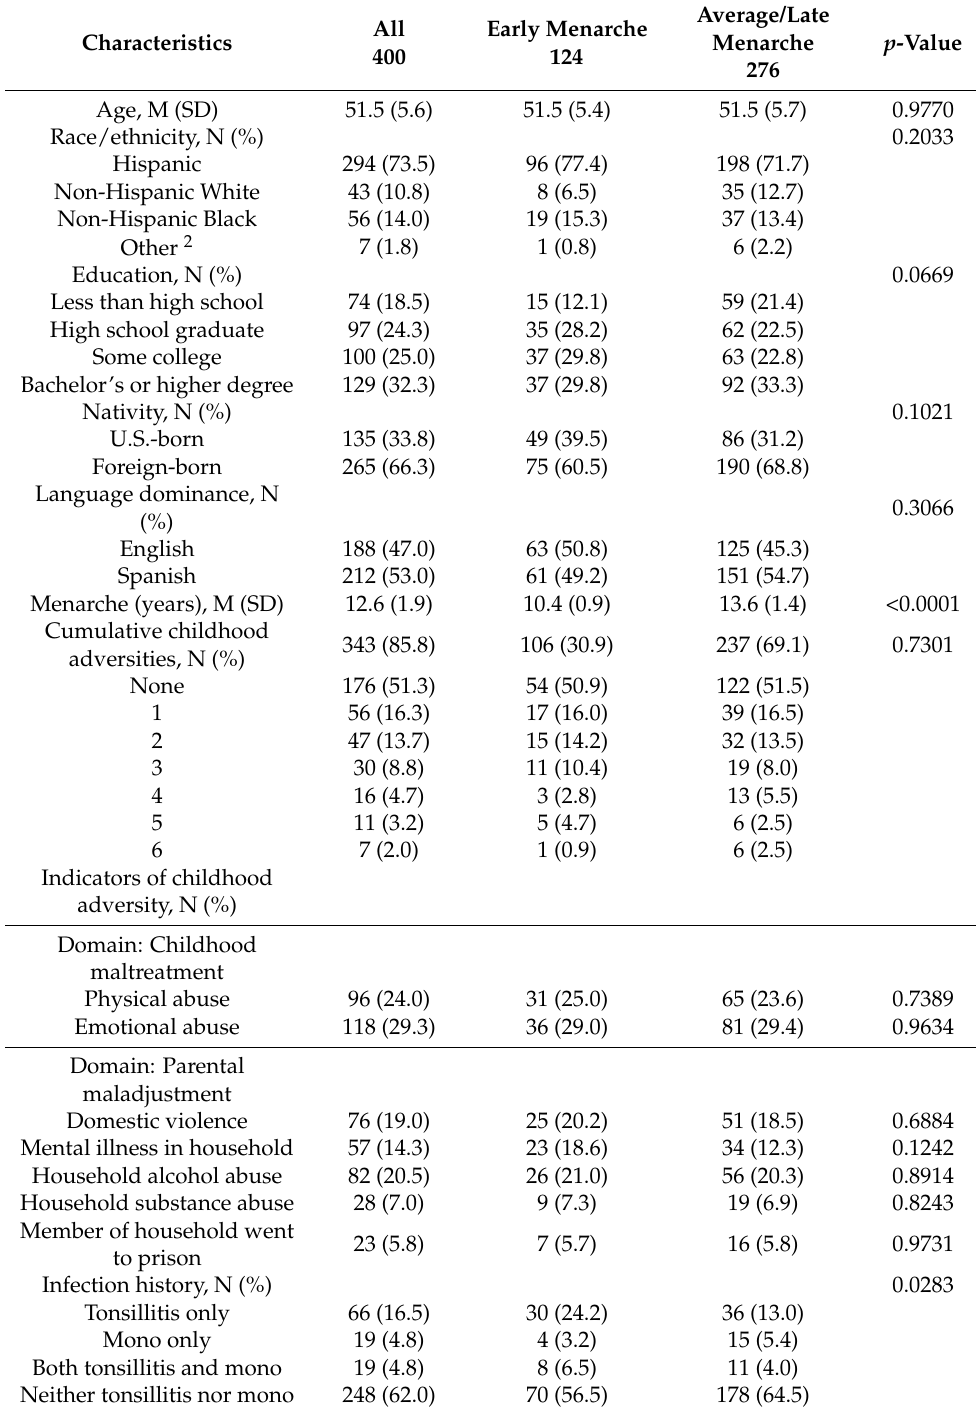
Table 1. Distribution of sociodemographic characteristics, childhood adversities, and early childhood infection for women by menarche status (early, average/late 1 ; N =